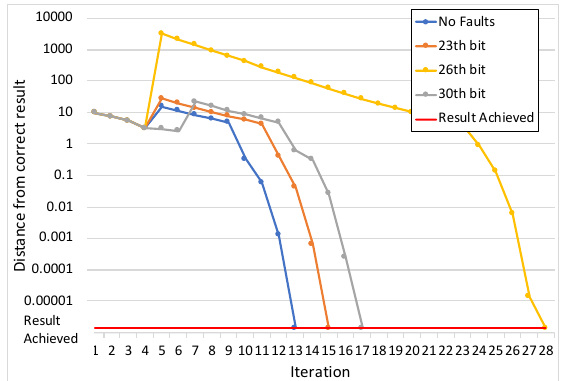
Figure 5. Evolution of the output from Newton–Raphson algorithm with faults injected in various bit positions at the 5th